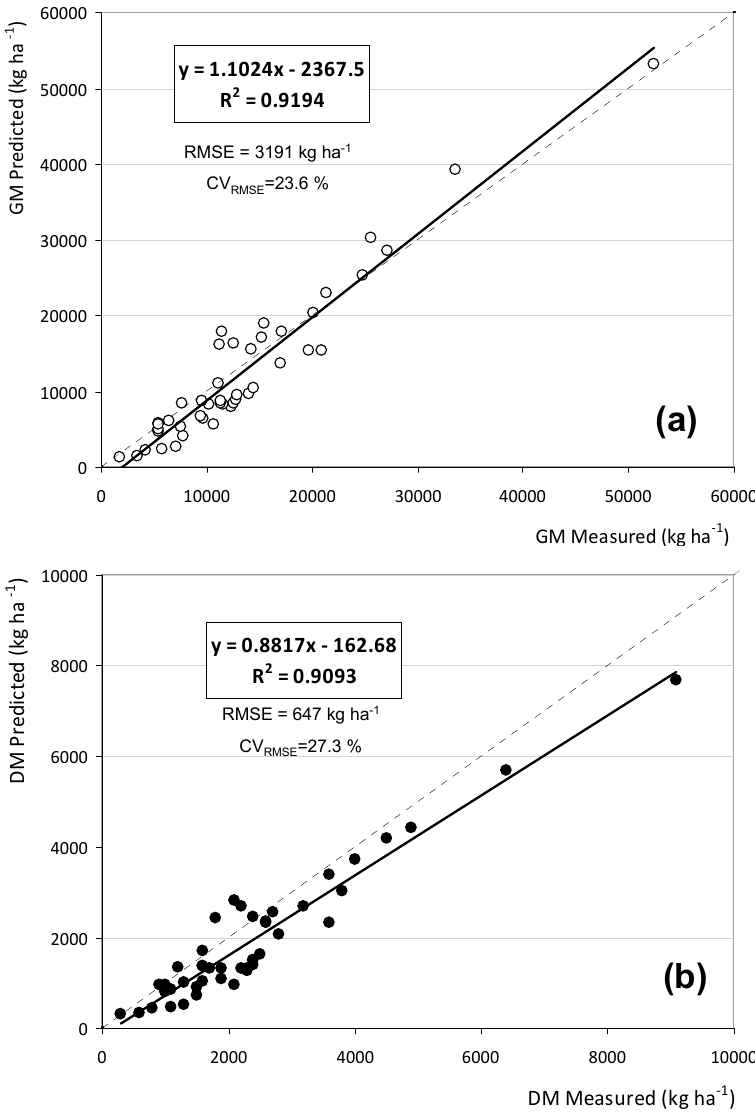
Figure 8. Relation between pasture productivity measured (( a ) green matter; ( b ) dry matter (DM)) in 2019, in eight experimental fields (“Azinhal”, ”Cubillos”, “Grous”, “Mitra B”, “Murteiras”, “Padres”, “Quinta França” and “Tapada”—validation phase), and pasture productivity predicted based on the equations obtained in calibration phase for pasture moisture content (PMC) > 80%. R 2 —coefficient of determination; RMSE—root mean squared error; CV RMSE —coefficient of variation of root mean squared error.